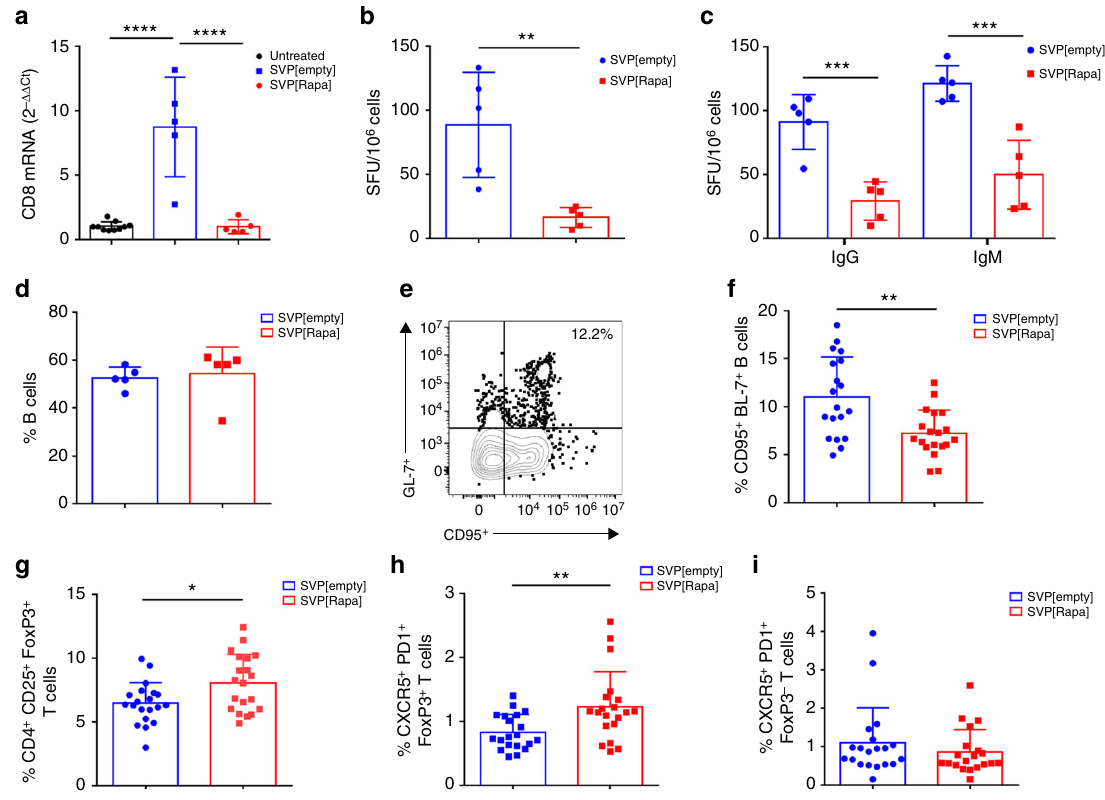
Fig. 4 Inhibition of anti-AAV8 capsid cellular and humoral responses with SVP[Rapa] co-administration. a CD8 T cell in fi ltrates in the liver. Livers from animals treated in Fig. 1a were collected after killing on day 53 and evaluated for CD8 mRNA expression by quantitative PCR using the ΔΔ C t method relative to housekeeping gene and to average of untreated mice. b – d Male C57BL/6 mice were treated with 4 × 10 12 vg kg − 1 of AAV8-VP1 vector together with SVP[Rapa] or with SVP[empty] control. 14 days later, spleens were collected for B and T cell assays. b Analysis of T cell recall responses after overnight stimulation with an AAV8 peptide pool in splenocytes measured by IFN- γ ELISpot and c anti-AAV8 IgG and IgM secreting B cell responses in splenocytes measured by B ELISpot. d Frequency of B220 + CD19 + B cells in spleens measured by fl ow cytometry. e – i Male C57BL/6 mice were treated with 4 × 10 12 vg kg − 1 of AAV8-luc vector together with SVP[Rapa] or with SVP[empty] control. 14 days later, animals were sacri fi ced. e Gating of germinal center (GC) B cells (CD95 + GL7 + ) are shown in representative fl ow cytometry plot. Cells were gated on B220 + IgD − cells. Shown is a mouse from the SVP [empty] control group. f Frequency of GC B cells (CD95 + GL7 + ) in lymph nodes of treated mice determined by fl ow cytometry as shown in e ; g frequency of CD25 + FoxP3 + regulatory T cells in lymph nodes; h frequency of CXCR5 + PD1 + Foxp3 + follicular regulatory T (Tfr) cells and i frequency of CXCR5 + PD1 + FoxP3 − follicular helper T (Tfh) cells in lymph nodes. SVP[Rapa] treatment consisted of 200 µ g of rapamycin. Data are shown as mean ± s.d. Statistical analyses were performed by one-way ANOVA with Tukey post hoc test in a and by unpaired, two-tail t -test in b – d , f – i ( n = 5 in a – d , n = 20 in f – i . * p <